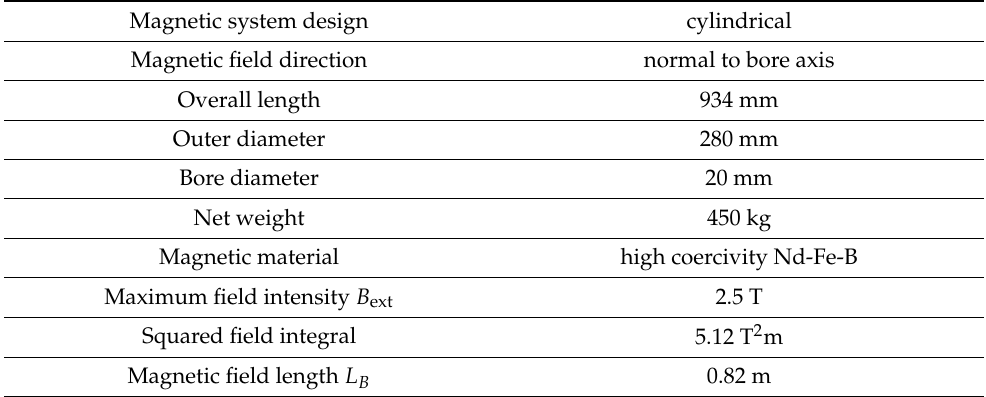
Table 3. Main characteristics of the dipole magnets designed and built by Advanced Magnetic Technologies & Consulting LLC, Troitsk, Russian